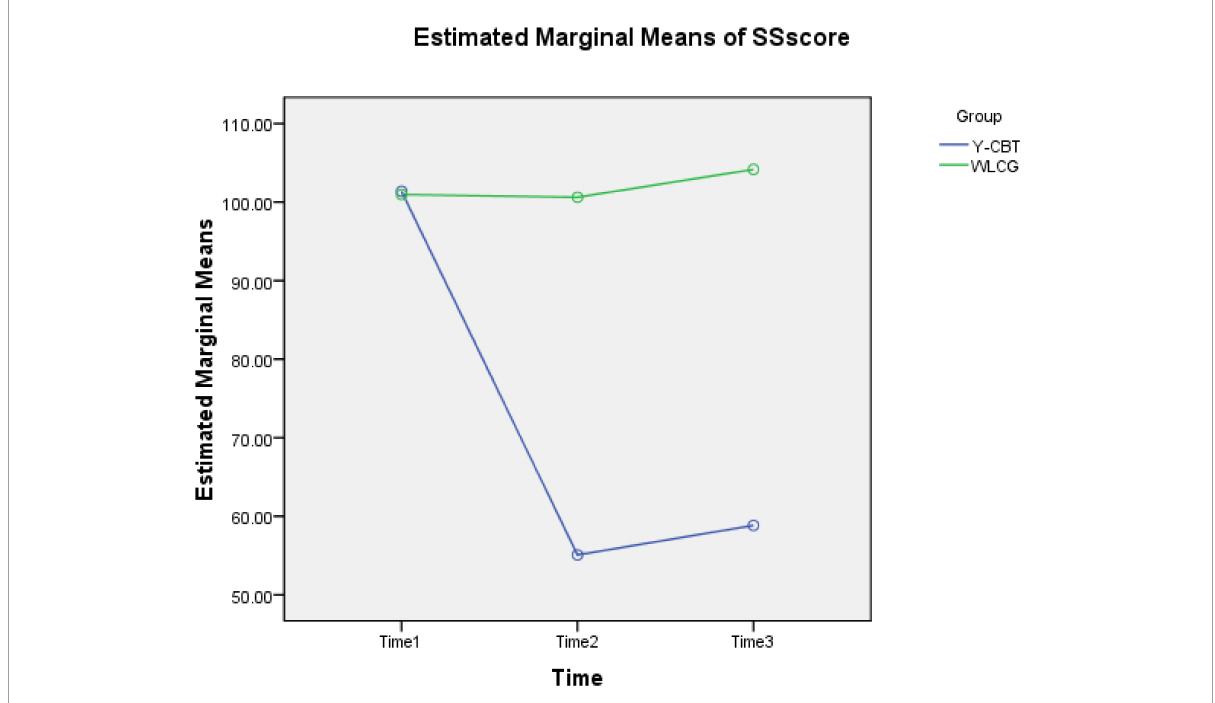
FIGURE3 Interaction effect of time and intervention on participants’ SS scores.